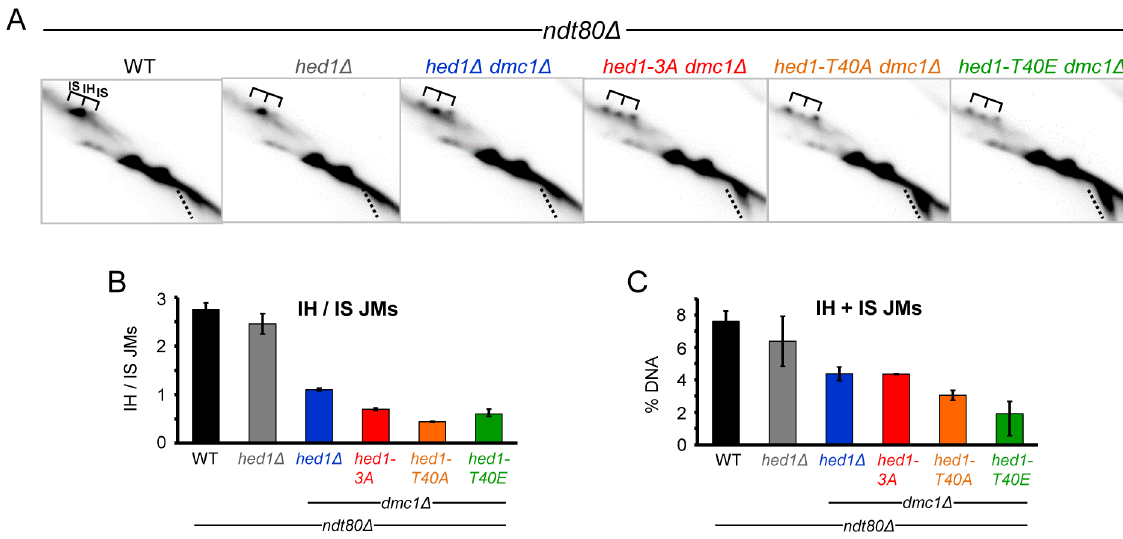
Fig 5. JM formation in dmc1 Δ ndt80 Δ strains containing different alleles of HED1 . ndt80 Δ , (NH2188), hed1 Δ ndt80 Δ (NH2223), dmc1 Δ hed1 Δ ndt80 Δ (NH2166), dmc1 Δ hed1-3A ndt80 Δ (NH2166::pNH302-3A 2 ) and dmc1 Δ hed1-T40A ndt80 Δ (NH2166::pNH302-T40A 2 ) and dmc1 Δ hed1-T40E ndt80 Δ (NH2166::pNH302-T40E 2 ) diploids were incubated in Spo medium for seven hours. The DNA was crosslinked using psoralen and digested with XhoI. Southern blots of two-dimensional gels were probed as described in [61]. A. Two-D gels. Brackets indicate the positions of the IH and two IS JMs. Dotted lines indicate DSBs. B. Quantification of JMs from two separate experiments, one of which is shown in Panel A. Error bars indicate the range. C. Quantification of the percentage of JMs (IH + IS) in two separate experiments, one of which is shown in Panel